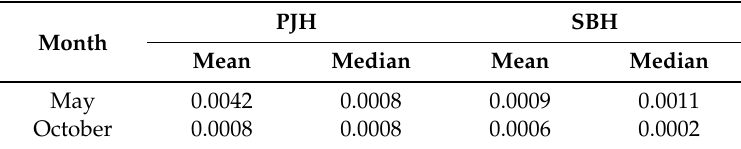
Table 1. Emission factors (EF5). Mean and median calculated from all porewater samples at each coastal aquifer.